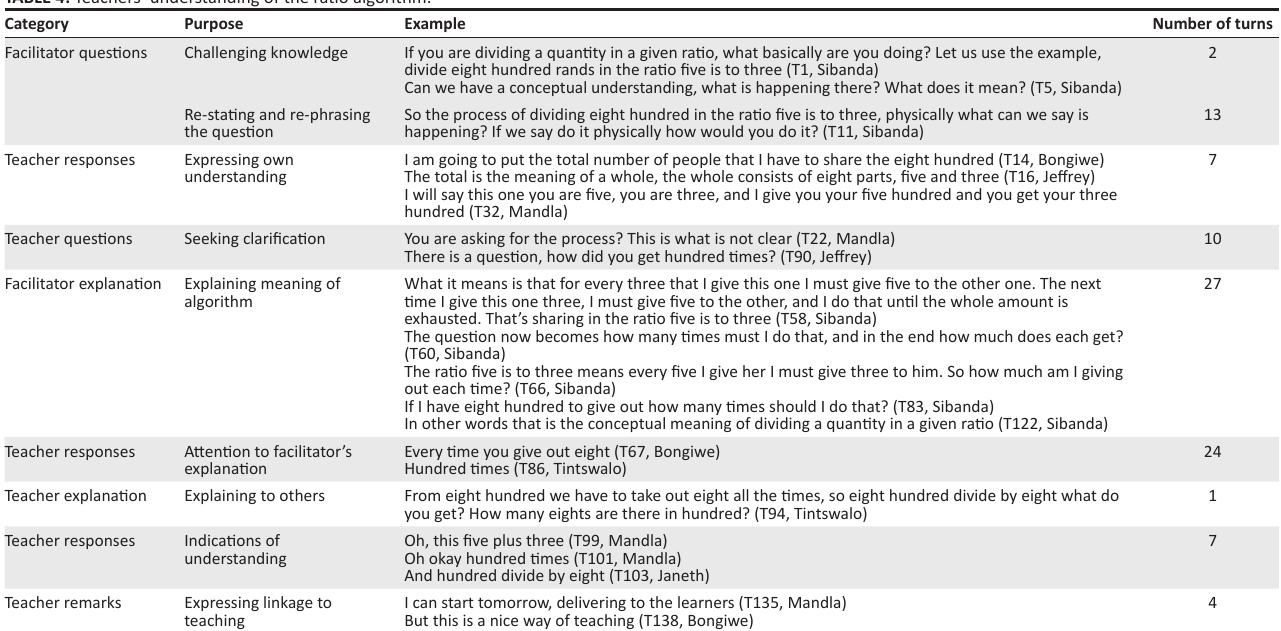
TABLE 4: Teachers’ understanding of the ratio algorithm.